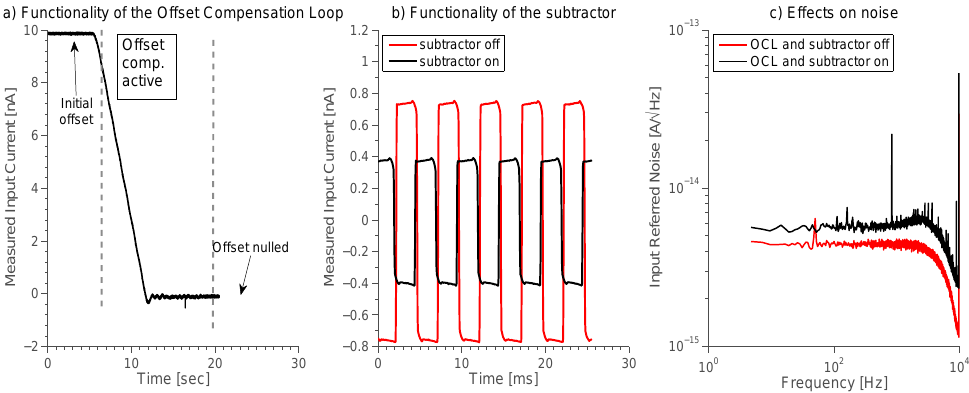
Figure 13. ( a ) Functionality of the OCL. An offset in the nA range usually exists at the beginning of the experiment. The OCL changes the DC component of the applied stimulus v C until a zero current is recorded ( i.e. , V OUT = V CM ); ( b ) Functionality of the subtractor. A 10 pF capacitor is connected to the input while a 100 mVpp triangular wave at 200 Hz is applied as v C signal leading to a 800 pApp current square wave flowing through the input. The input current is overestimated when the subtractor is turned-off; ( c ) Effect of the OCL on the input-referred noise. When the OCL is activated and a stimulus ‘ ‘ signal v STIM is applied, the noise rises from 4 fA/ Hz to 6 fA/ Hz due to noise sources in the OCL. Note that v C is filtered with an external 10 nF